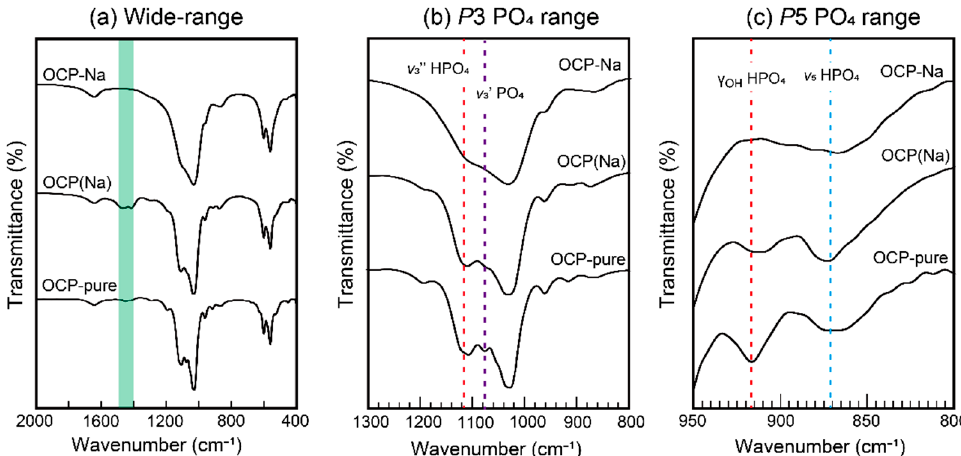
Figure 2. Transmitting FT-IR spectra (KBr method) of the treated samples. ( a ) Wide range. The green square corresponds to CO 3 adsorption. ( b ) P 3 PO 4 vibration; the red and purple broken line corresponds to the P 3 PO 4 vibration. ( c ) P 5 PO 4 vibration.